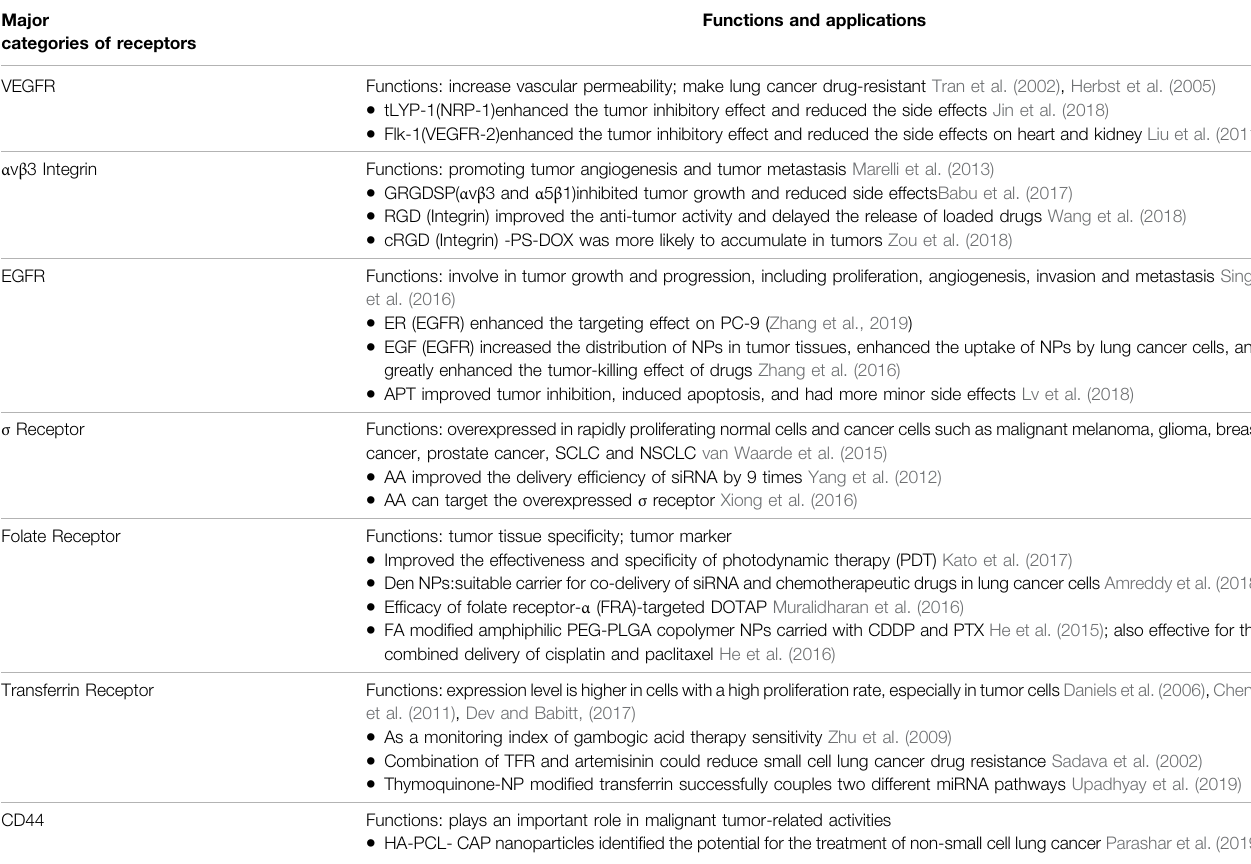
TABLE 1 | Receptors: principal categories, functions, and applications. Major categories of receptors